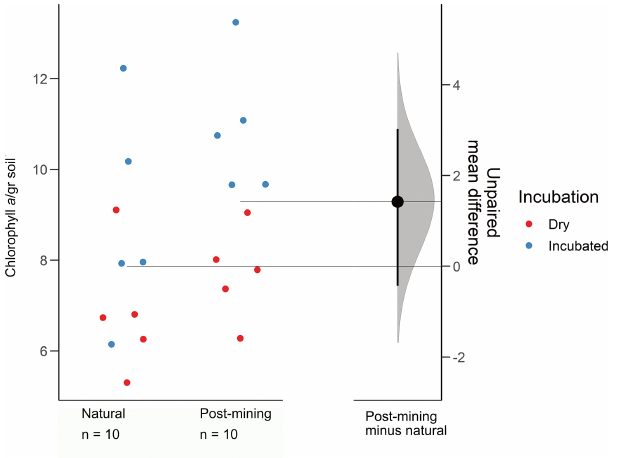
Figure 3. Estimation plots of chlorophyll a concentrations. Dots represent the biocrust samples, and colors represent either dry or incubated